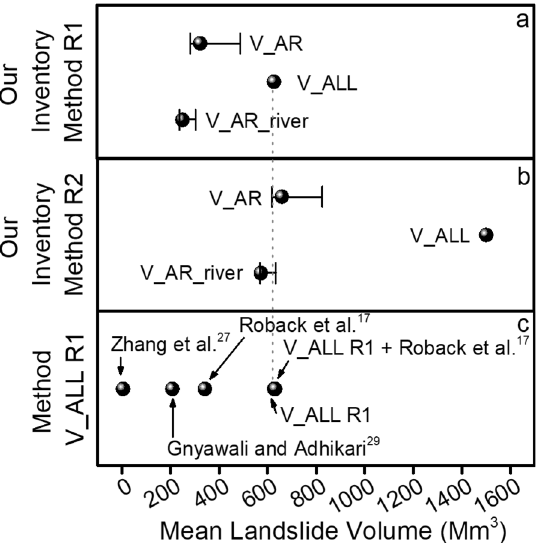
Figure 4. ( a ) Mean landslide volume (Mm 3 ) for the three methods based on R1. ( b ) Mean landslide volume (Mm 3 ) for the three methods based on R2. In ( a , b ) horizontal bars indicate the range of variation due to a change in the soil thickness eroded along the runout area (0.5 and 3 m). ( c ) Mean landslide volume (Mm 3 ) for the earthquake-induced landslide inventories in Nepal: Roback et al. 17 ; Gnyawali and Adhikari 29 ; Zhang et al. 27 and the integration in our inventory of landslides by Roback et al. 17 located in unmapped areas (V_ALL R1 + Roback et al. 17